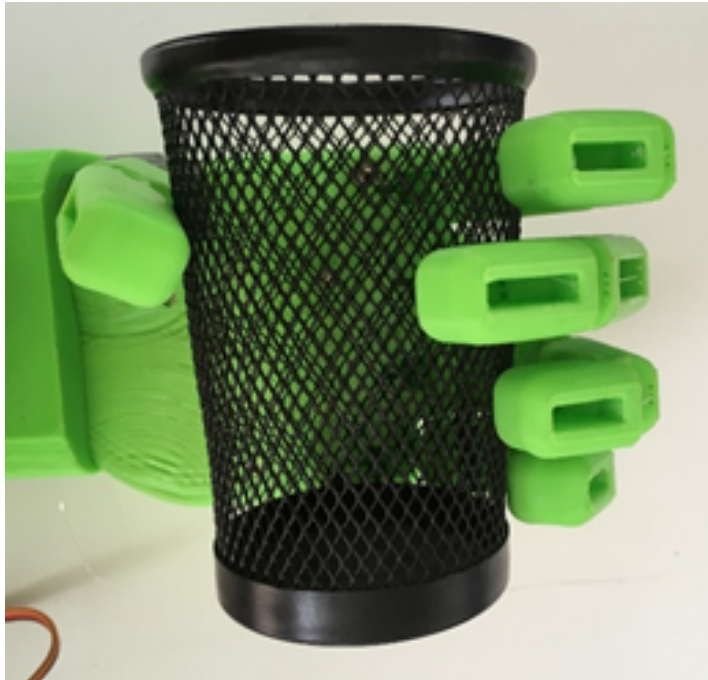
Figure 13. Full palmar grip while holding a conical object.